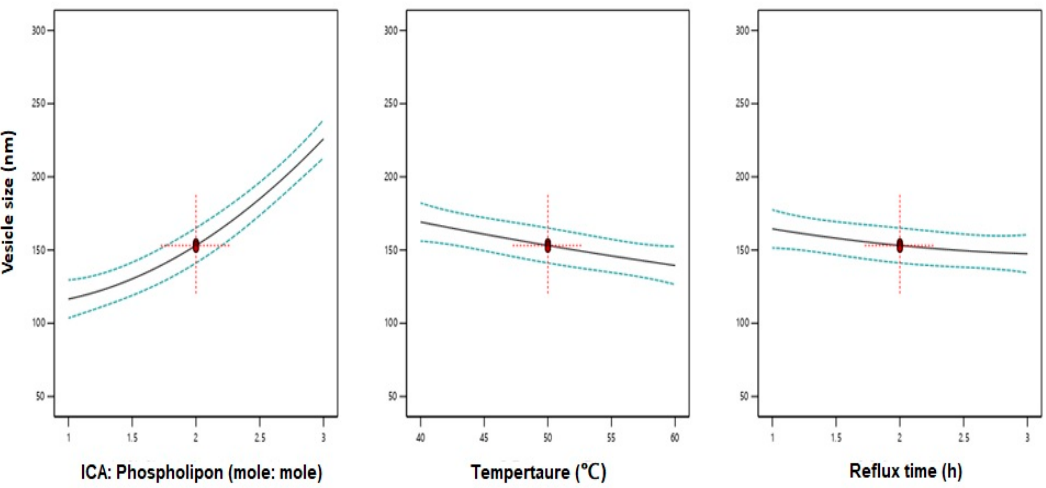
Figure 2. Main effect plots of ICA:Phospholipon ® 90H molar ratio (X 1 ), temperature (X 2 ), and reflux time (X 3 ) on the vesicle size of ICA-phytosomes.